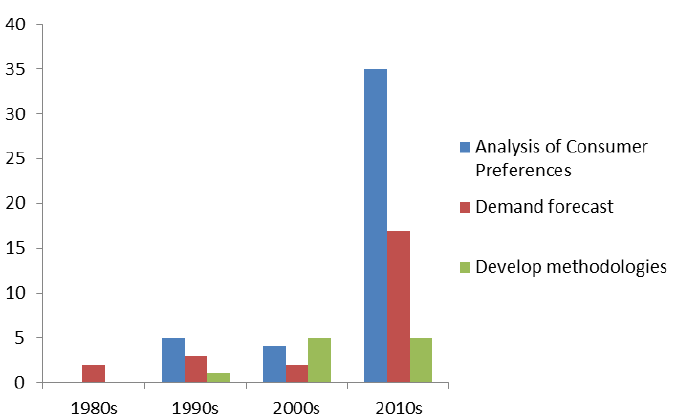
Figure 4. CM studies by scope.